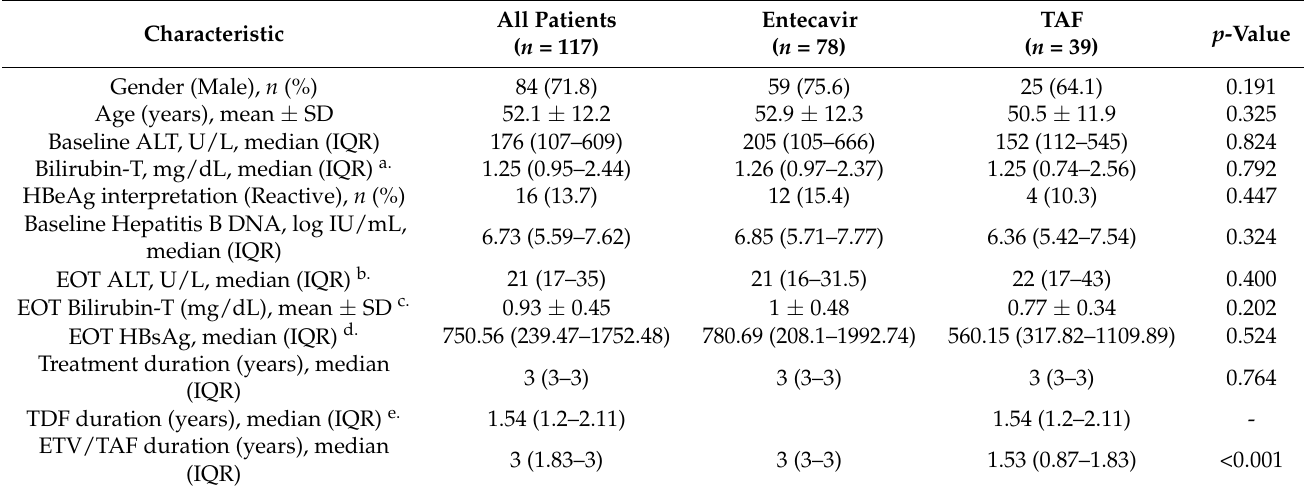
Table 1. Clinical features of the study